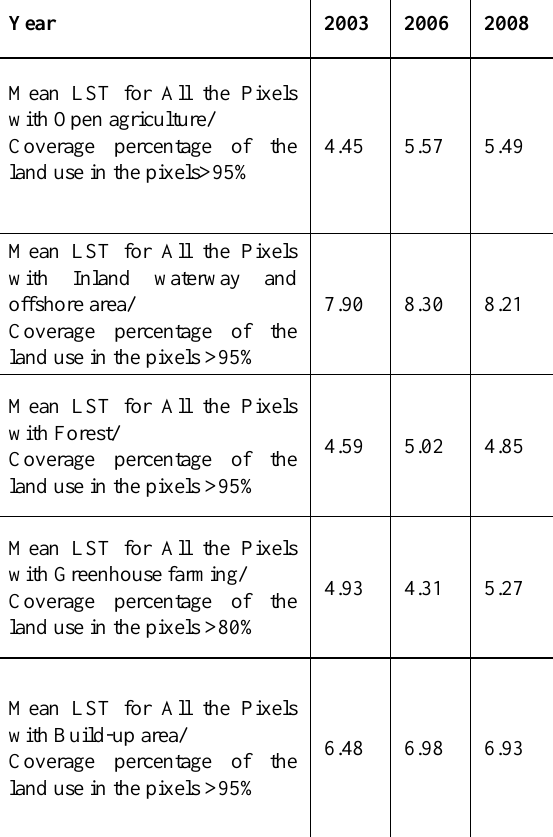
Table 1. The average of mean yearly night LST for